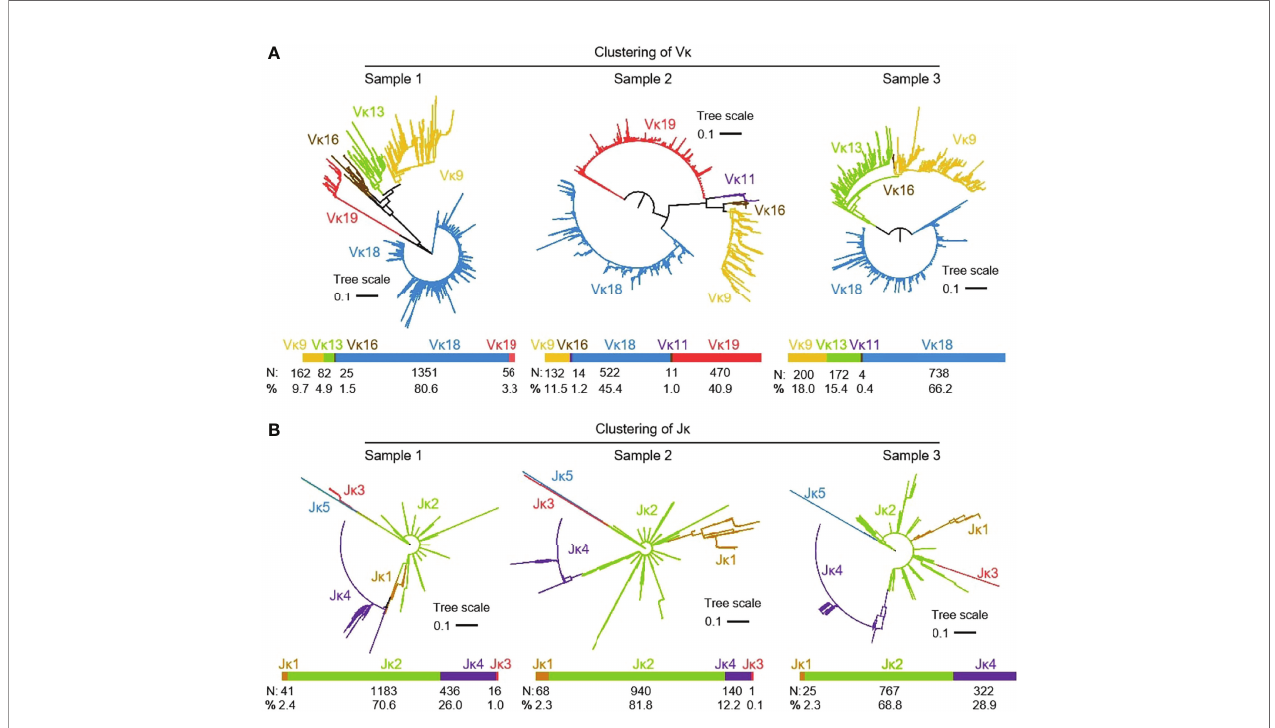
FIGURE 6 | The V k and J k genes usage in yak IgL ( k ). (A) Expression of the yak V k ; (B) Expression of the yak J k